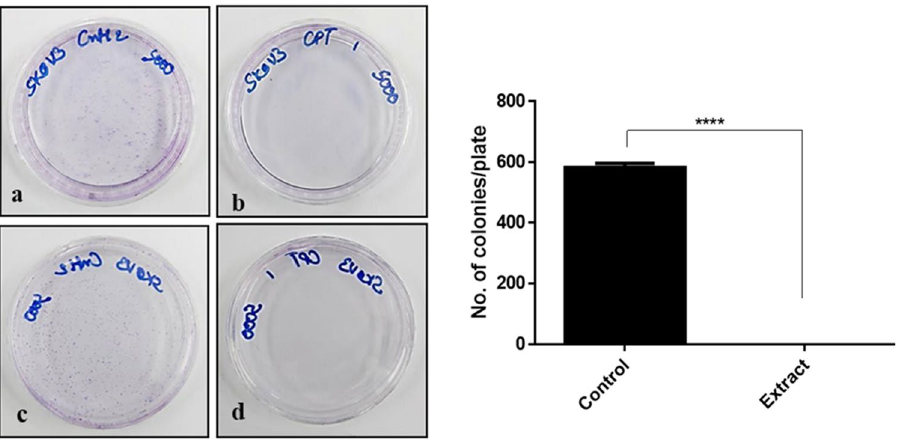
Figure 4. Complete inhibition of colony formation in the SKOV3 cell line by A. burnsii extract at IC 25 . SKOV3 control plates showed colony formation ( a , c ), whereas the treated plates showed no colony formation ( b , d ).